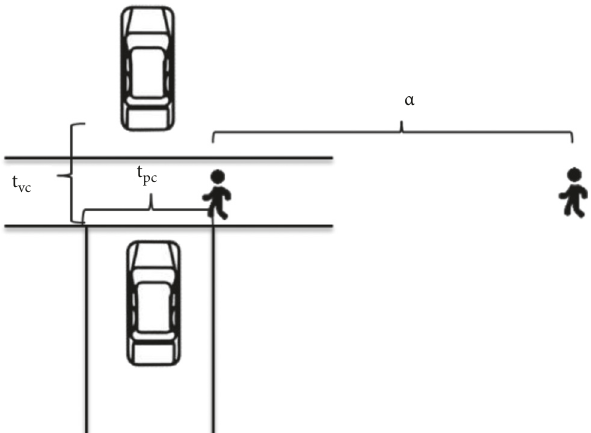
Figure 2: Diagram of safe gap for pedestrians yield.